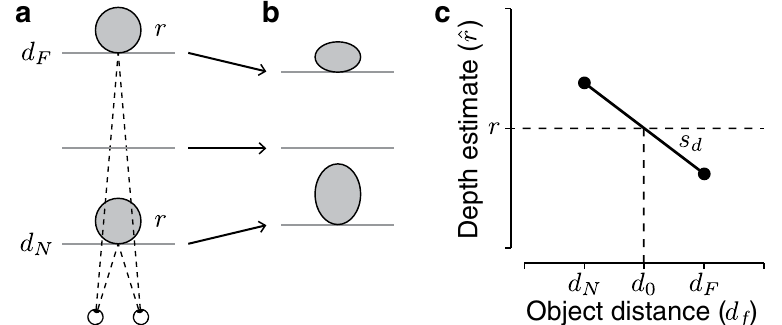
Figure 1. Shape from stereopsis. ( a ) Two objects of the same size r are placed at two distances ( d N and d F ). ( b ) Due to wrong encoding of distance from ocular vergence, the close object is perceived farther and deeper and the far object is perceived closer and shallower. ( b ) A linear function of negative slope ( s d ) that represents the relationship between depth estimates and object